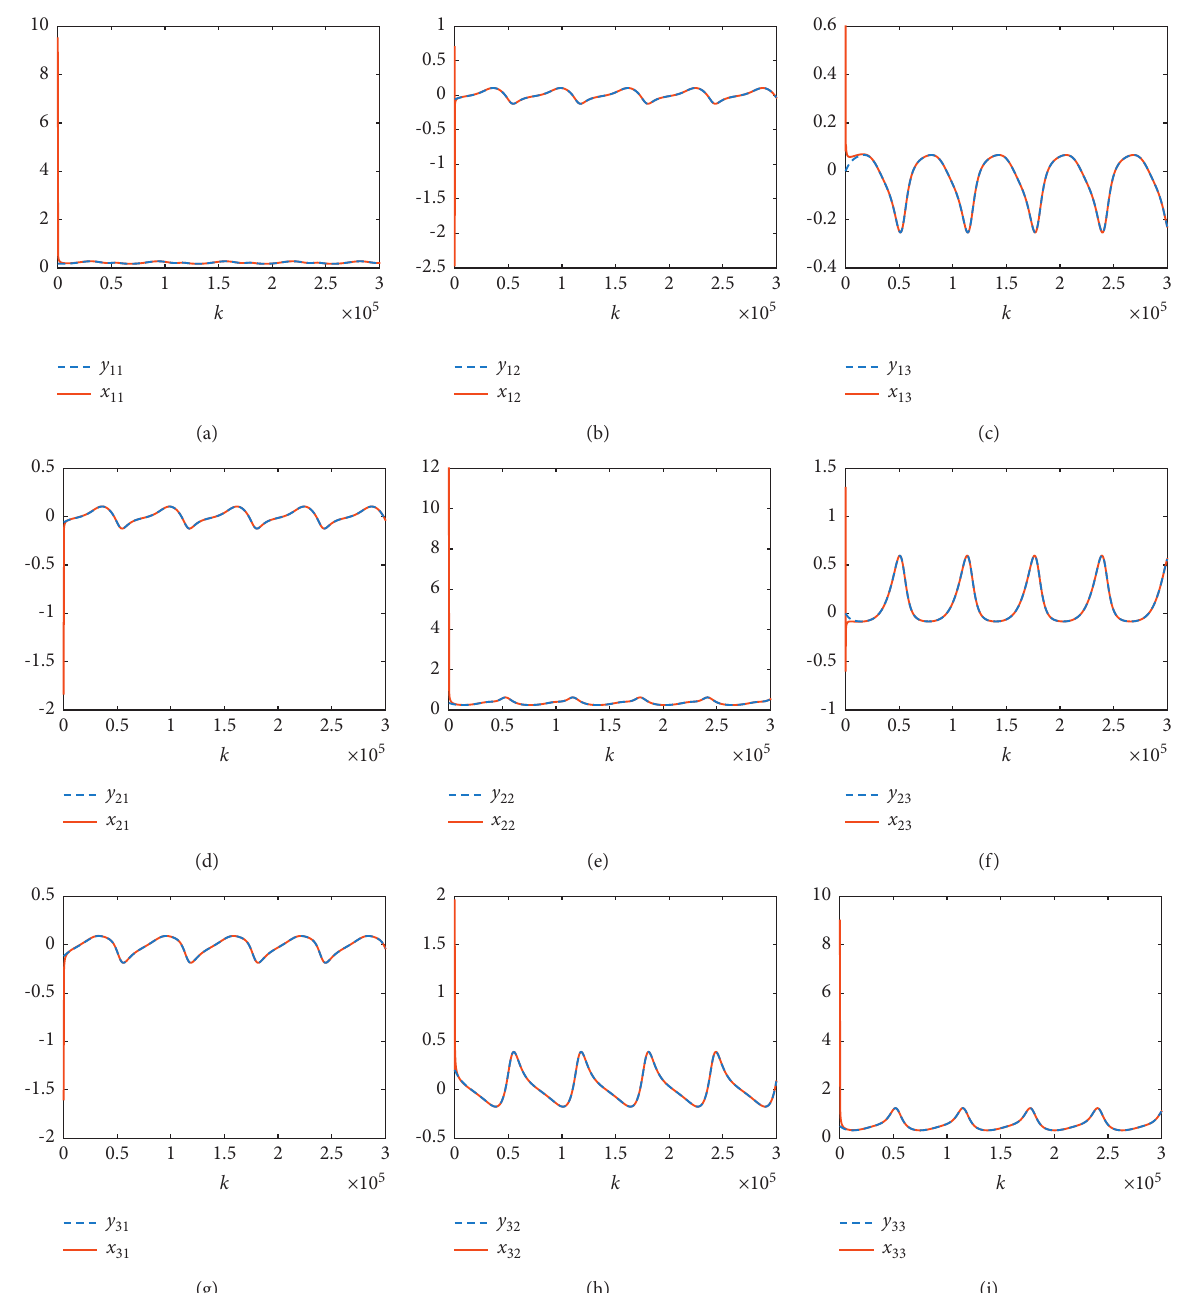
Figure 8: Solution trajectories synthesized by Y c � 2 . 0). (a) Trajectories of y Trajectories of